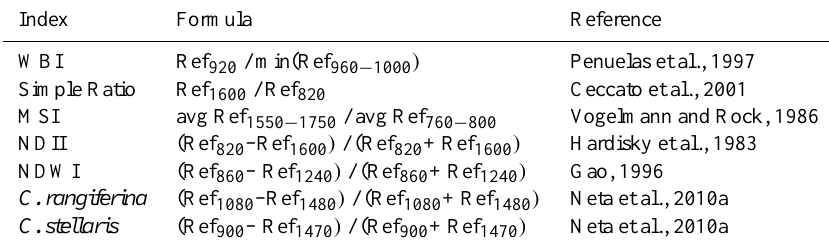
Table 1. Current and new spectral indices for detection of vegetation moisture content. Ref represents reflectance values in percentage (the wavelengths units are in nm), and min and avg refer to minimum and average, respectively. The mean R 2 values (of all sites and dates) between the log of these spectral indices and the log of the spatial resolution are in the following increasing order: C. rangiferina